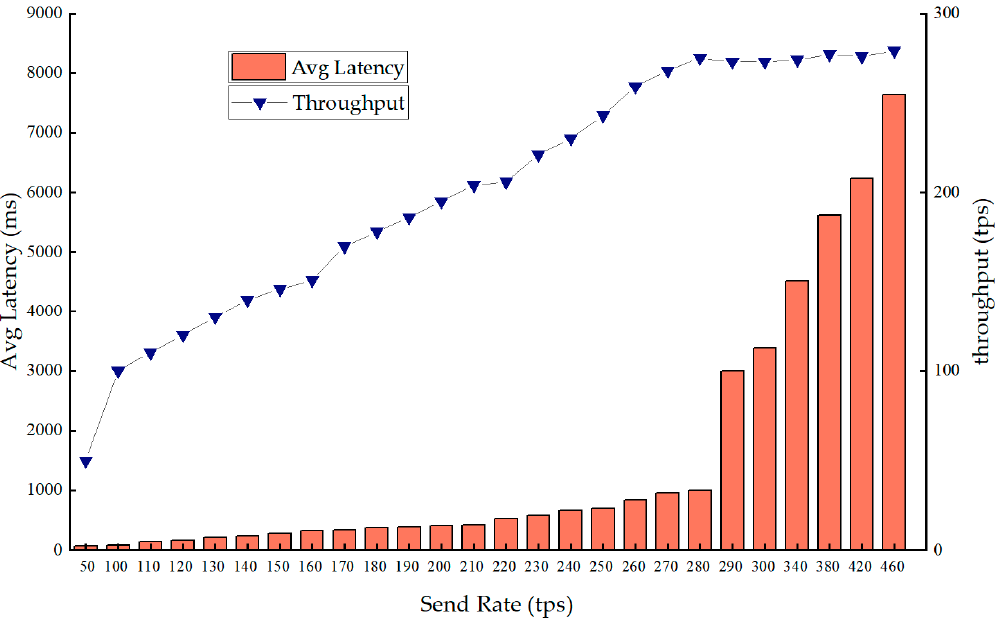
Figure 6. The performance of the throughput and latency.